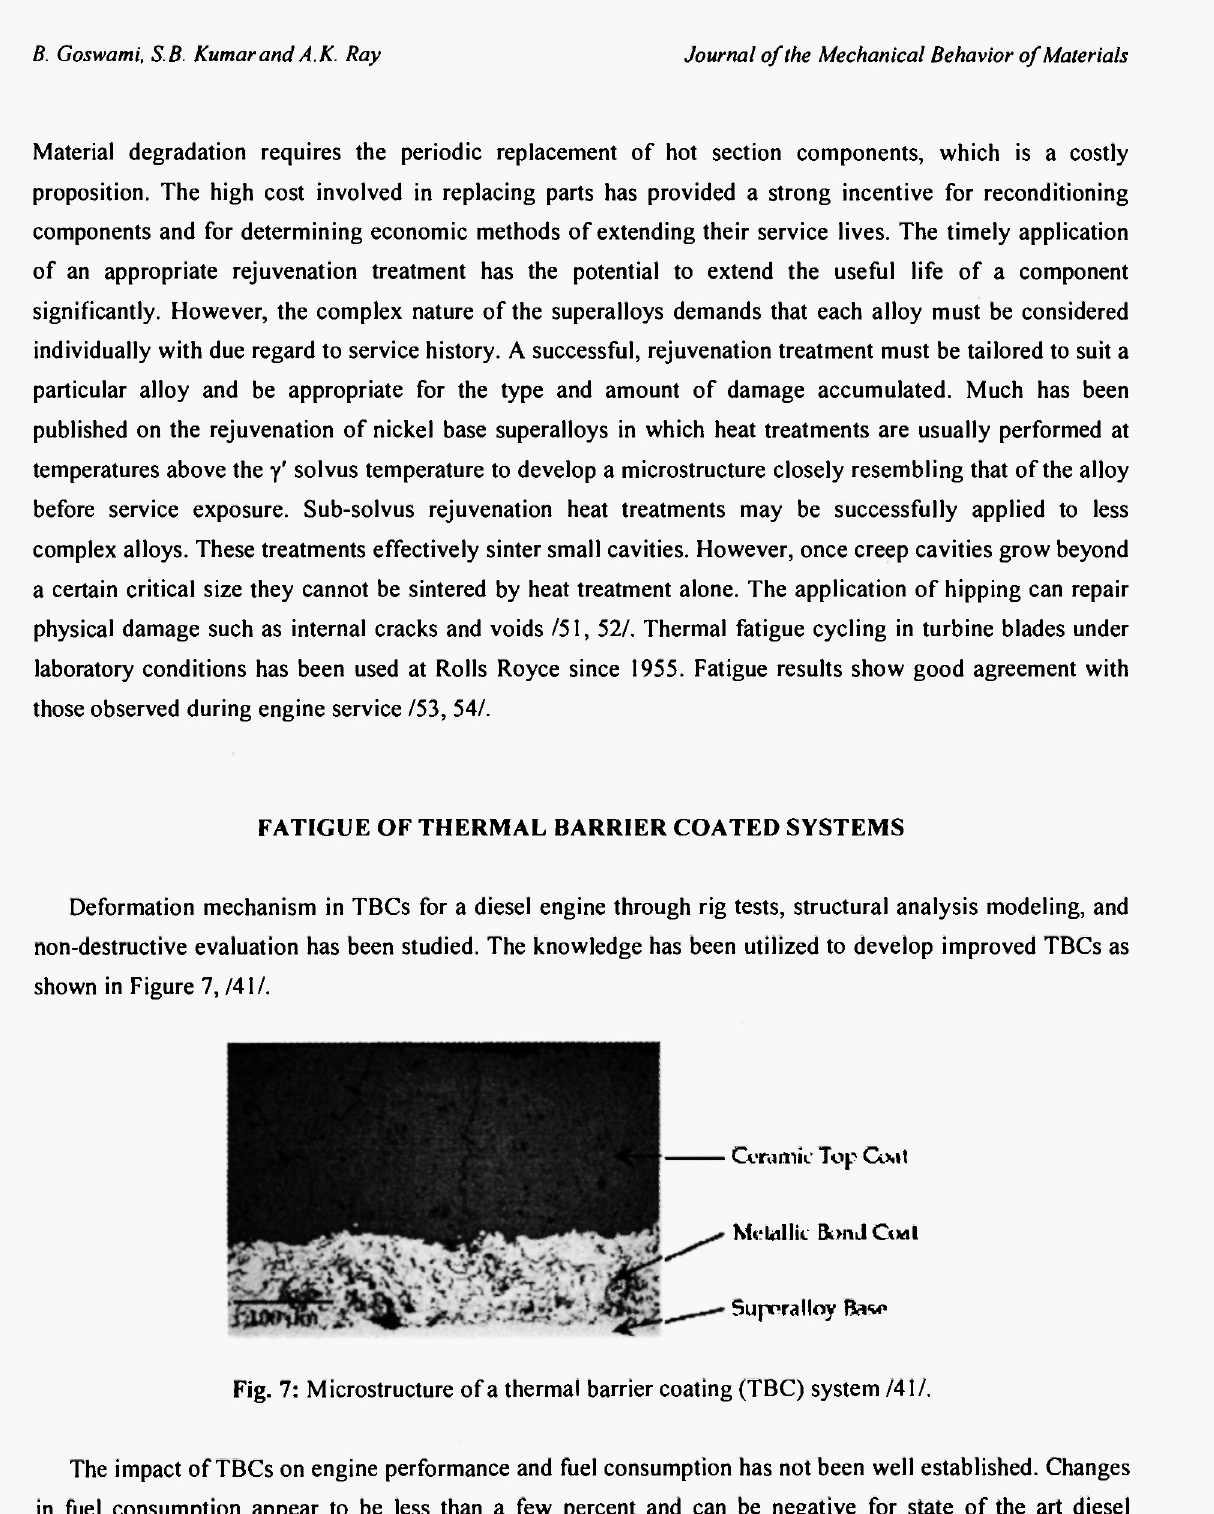
Fig. 7: Microstructure of a thermal barrier coating (TBC) system